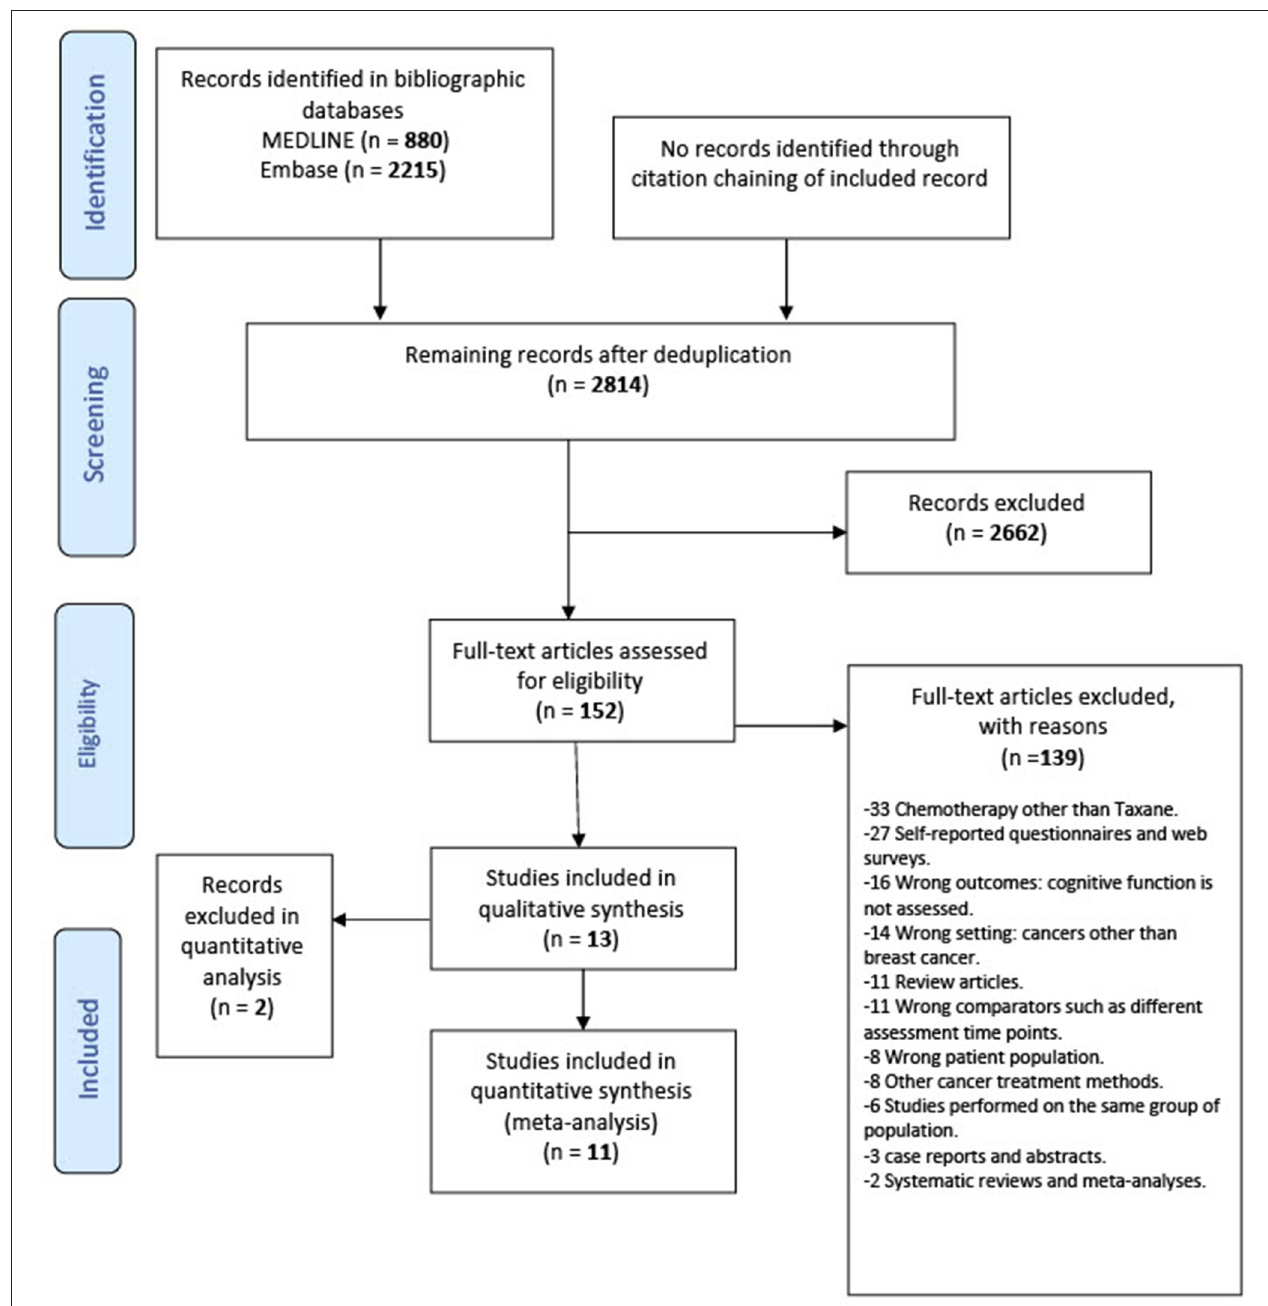
FIGURE 1 | Preferred reporting items for systematic review and meta-analysis statement (PRISMA) flowchart of the included